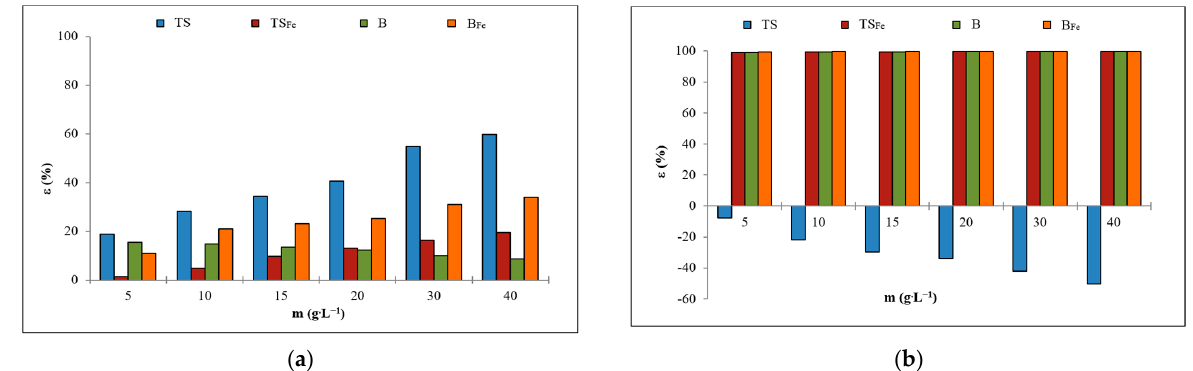
Figure 2. Adsorption efficiencies of B/B Fe and TS/TS Fe for selected ions: ( a ) NH 4+ ; ( b ) PO 43 − . PO 43 − adsorption occurred with high efficiency ( < 99%) on modified forms B Fe and TS Fe Table 2. Adsorption parameters for NH 4+ and PO 43 − on B, TS, B Fe and TS Fe . (Figure 2b). Due to its high alkalinity, B did not primarily support the adsorption of ani- Ion Sorbent